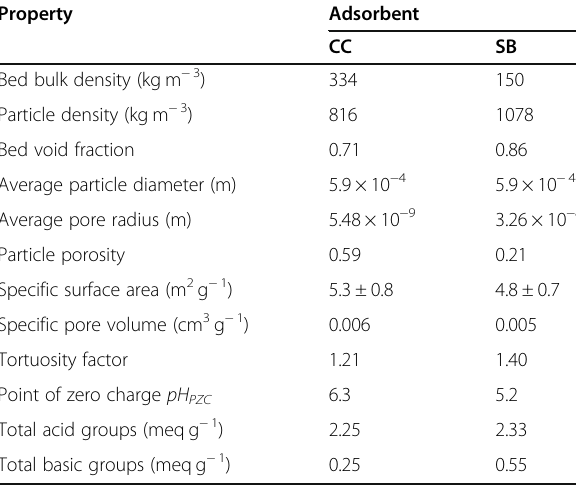
Table 1 Physicochemical properties of adsorbents [19, 25] Property